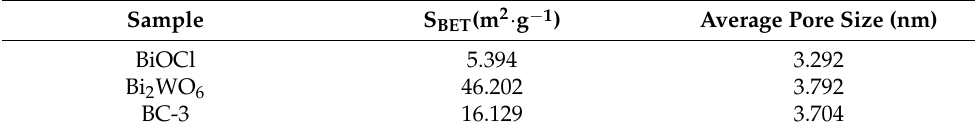
Figure 13. The TRPL spectra of pure BiOCl, Bi 2 WO 6 , and Bi 2 WO 6 /BiOCl nanocomposites. The Mott–Schottky plots of the samples are shown in Figure 14. The flat-band poten- tial (E fb ) could be determined based on the Mott–Schottky curves [16,47]. The positive slope of the curves suggests that the BiOCl and Bi 2 WO 6 are n-type semiconductor. Nota- bly, the E fb values of BiOCl and Bi 2 WO 6 were determined to be − 0.47 and − 0.98 V (vs. Ag/AgCl), respectively. Therefore, the CB potential values of the BiOCl and Bi 2 WO 6 were − 0.25 and − 0.76 V (vs. NHE, pH = 7), respectively [23,31]. Based on these results, the va- lence band (VB) positions were determined to be 3.06 and 1.90 V. These results indicate